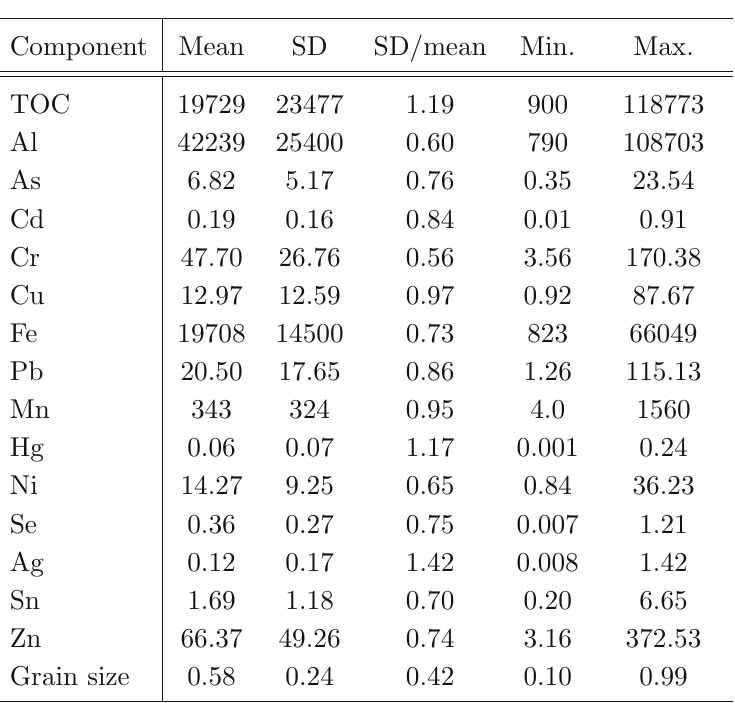
Table 1 Basic statistics of the input data